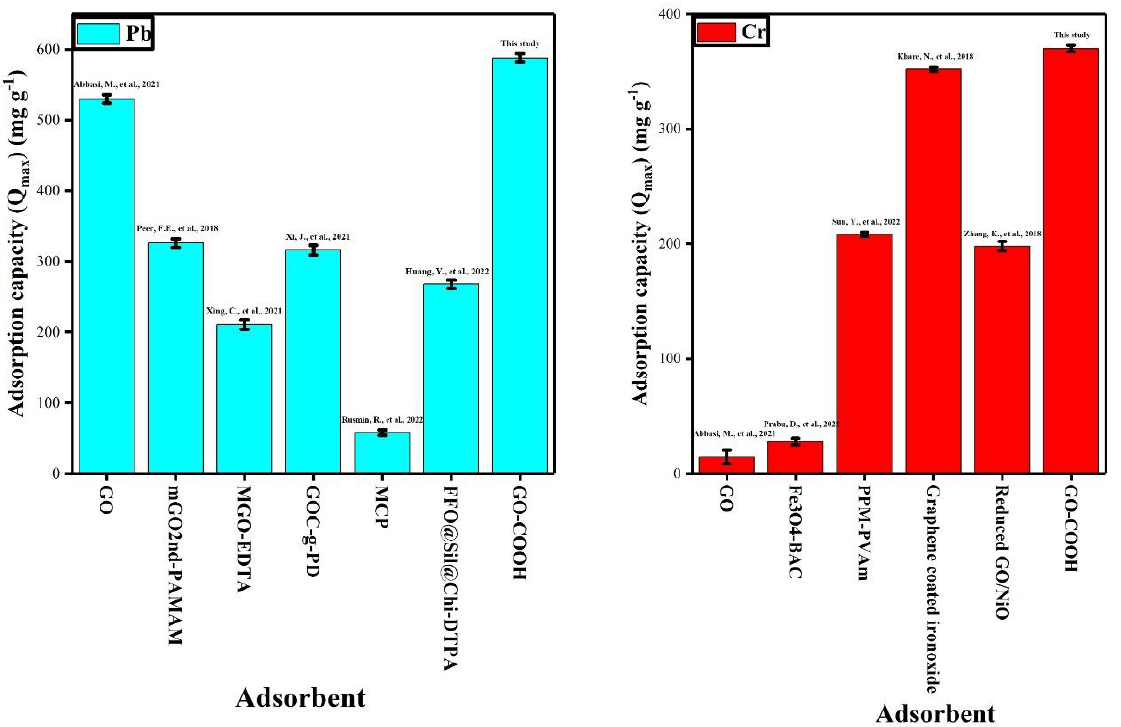
Figure 8. Different adsorbents with their effectiveness for relative metal ions adsorption. (TS